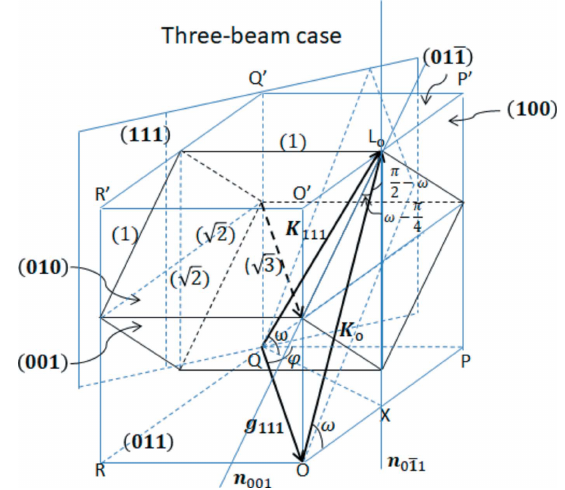
Figure 2 Schematic of the relation between K o , the wavevector of the incident X-rays, and n 001 , the (001) surface normal, or n , the 0 (cid:2) 111 (cid:4) (cid:5) surface 0 (cid:2) 111 normal. Angles ð (cid:3)= 2 Þ (cid:2) ! and ! (cid:2) ð (cid:3)= 4 Þ correspond to direction cosines (cid:10) o of K o to n 001 and n , 0 (cid:2) 111